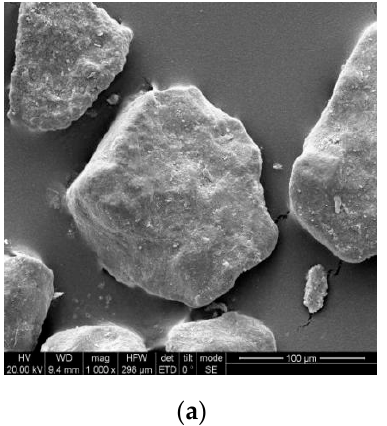
Figure 9. SEM of DS and FAC: ( a ) DS; ( b ) FAC.